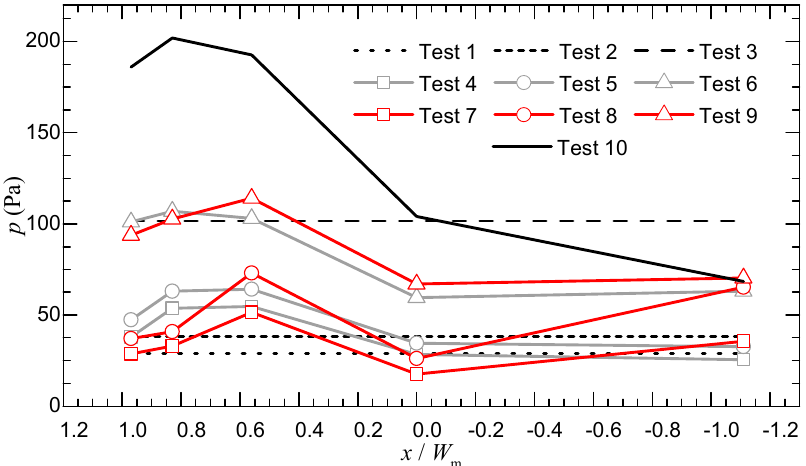
Figure 8. Plane distribution of the oscillatory amplitude of the excess pore pressure amplitude along the flume length.